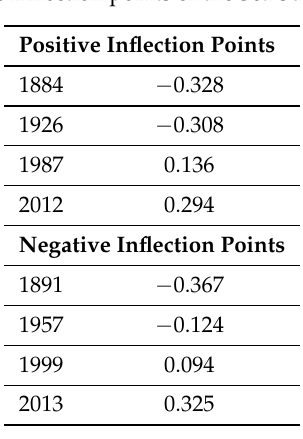
Table 2. Positive and negative inflection points of the Sea Surface Temperature anomalies.